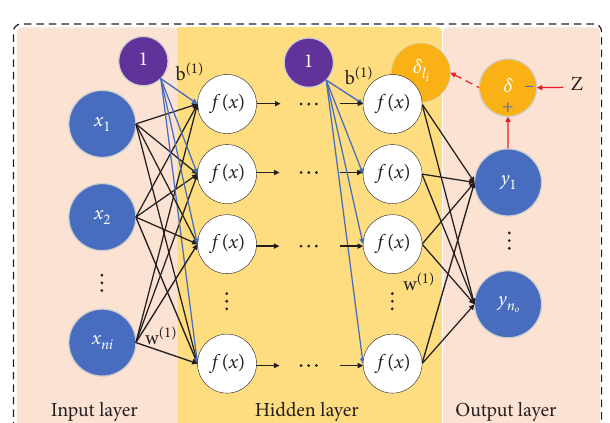
Figure 3: The structure of the BP neural